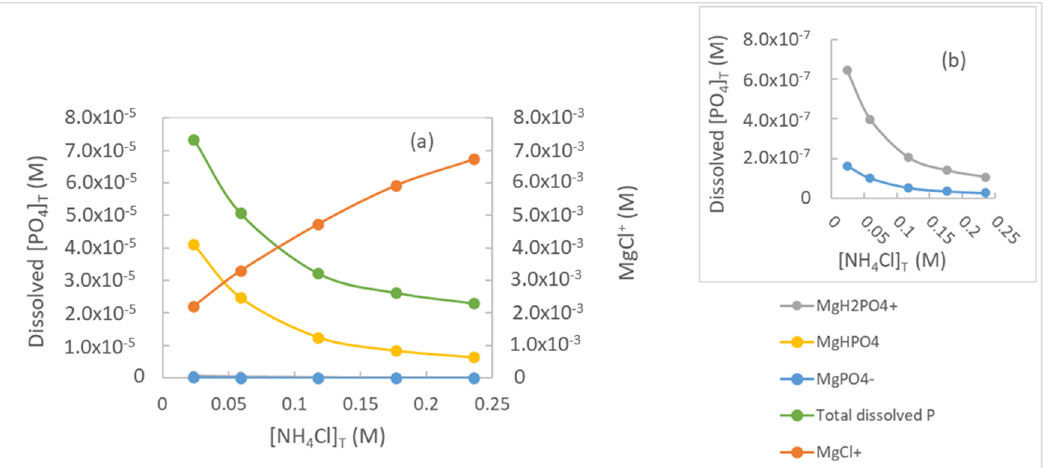
Figure 5. Panel ( a ): Concentrations of magnesium orthophosphate complexes (left y-axis), along with total dissolved [PO 4 ] T (left y-axis) and MgCl + (right y-axis), all calculated with MINEQL+. Panel ( b ): Inset for panel ( a ) showing a smaller y-axis scale.